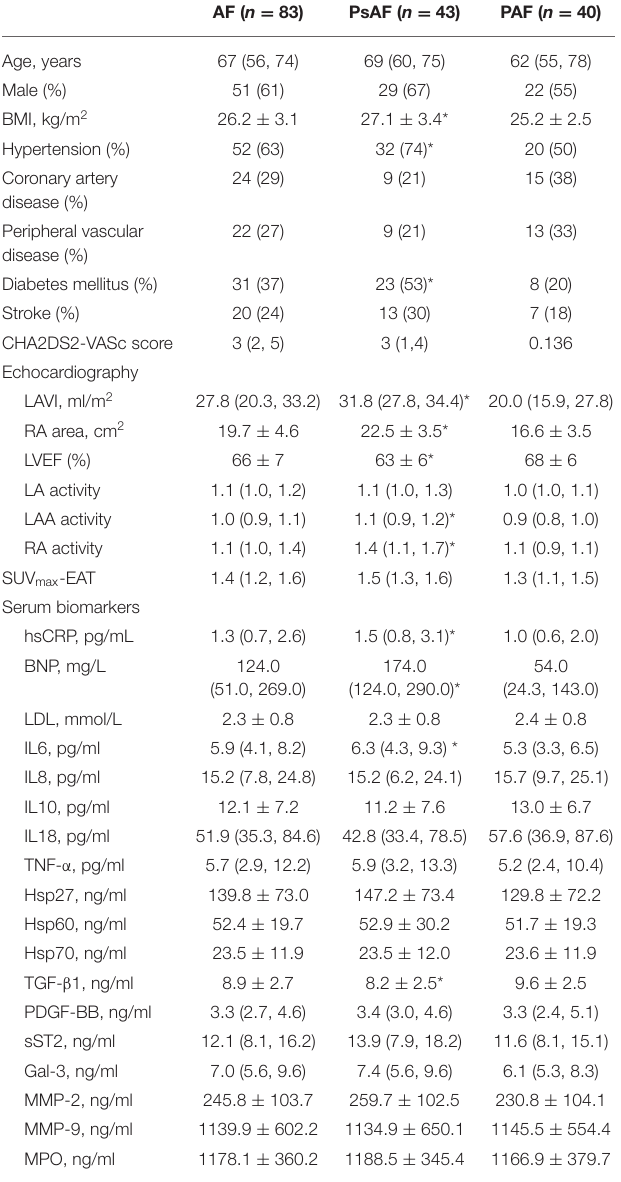
TABLE 1 | Patients’ characteristics.